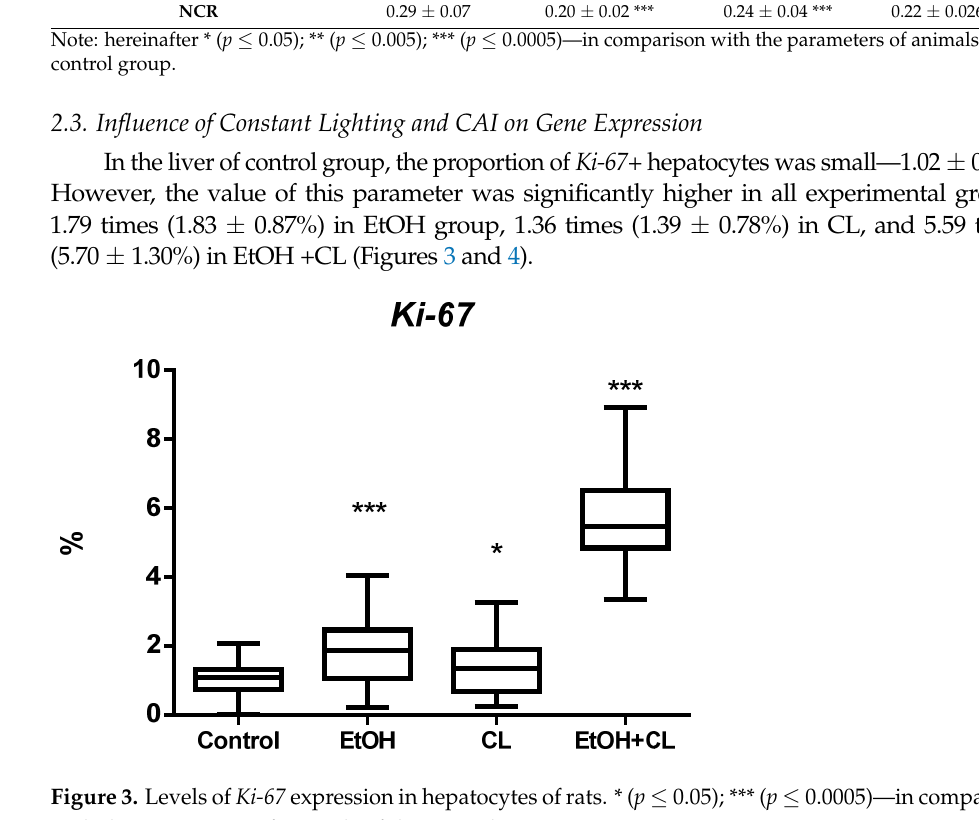
Figure 3. Levels of Ki-67 expression in hepatocytes of rats. * ( p ≤ 0.05); *** ( p ≤ 0.0005)—in comparison with the parameters of animals of the control group.